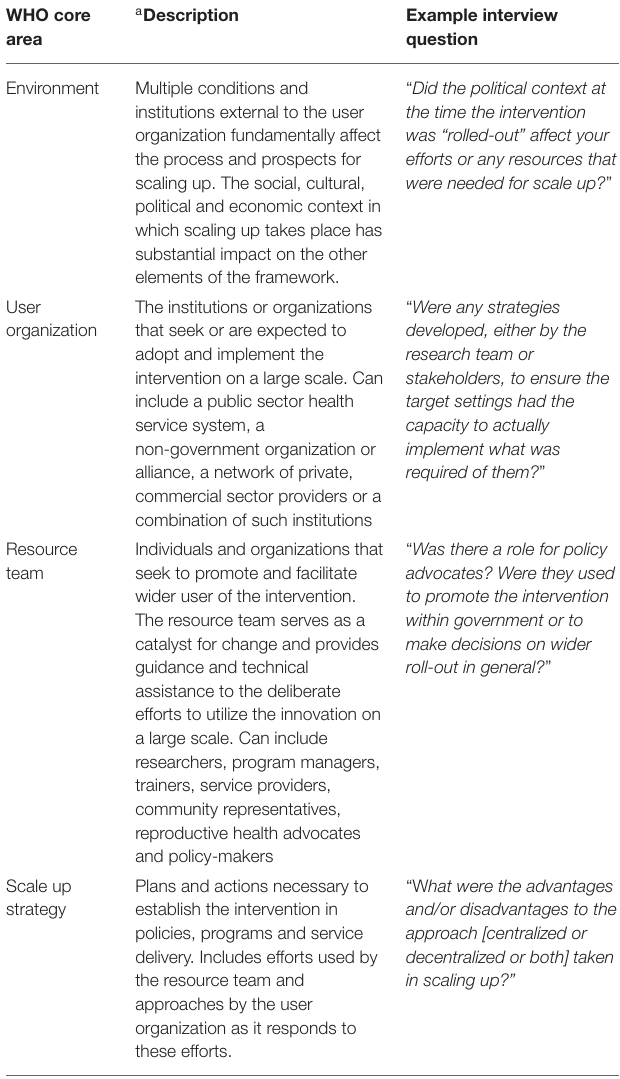
TABLE 2 | Application of the four core areas of the WHO ExpandNet framework for scaling up in interviews. WHO core